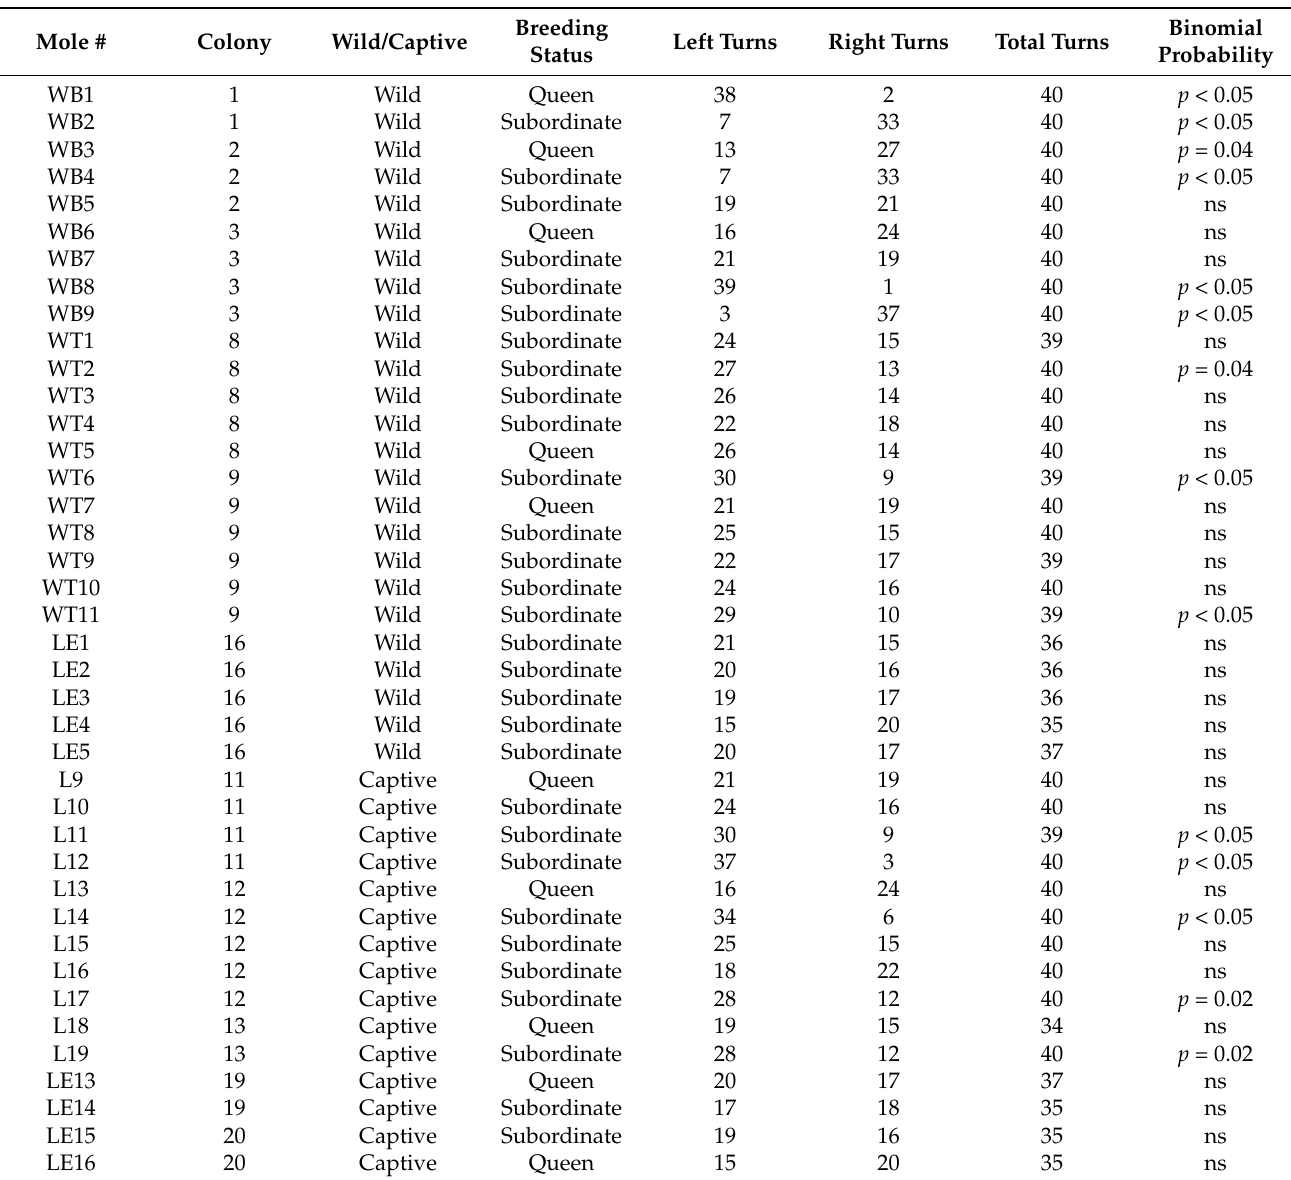
Table 1. Damaraland mole rat ( Fukomys damarensis ) queen and non-breeding subordinate left- or right-turning bias preference from wild-caught and captive populations within their respective colonies. For each individual, the total numbers of left and right turns are given with the total number of trials, together with the two-tailed binomial significance ( p or ns for not significant). Significance of the binomial probability demonstrates that an individual is